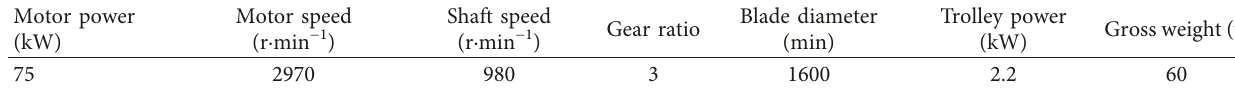
Table 1: Technical parameters of stone cutting machine.